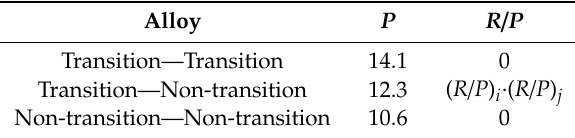
Table 3. The parameters of alloy system, data from